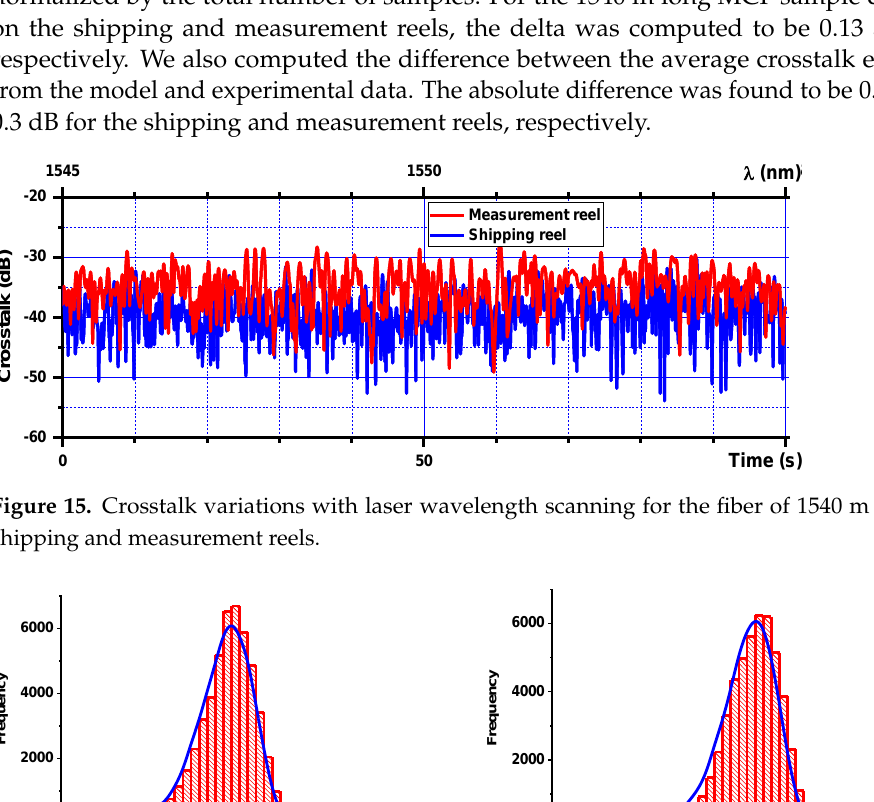
Figure 15. Crosstalk variations with laser wavelength scanning for the fiber of 1540 m length on shipping and measurement reels.